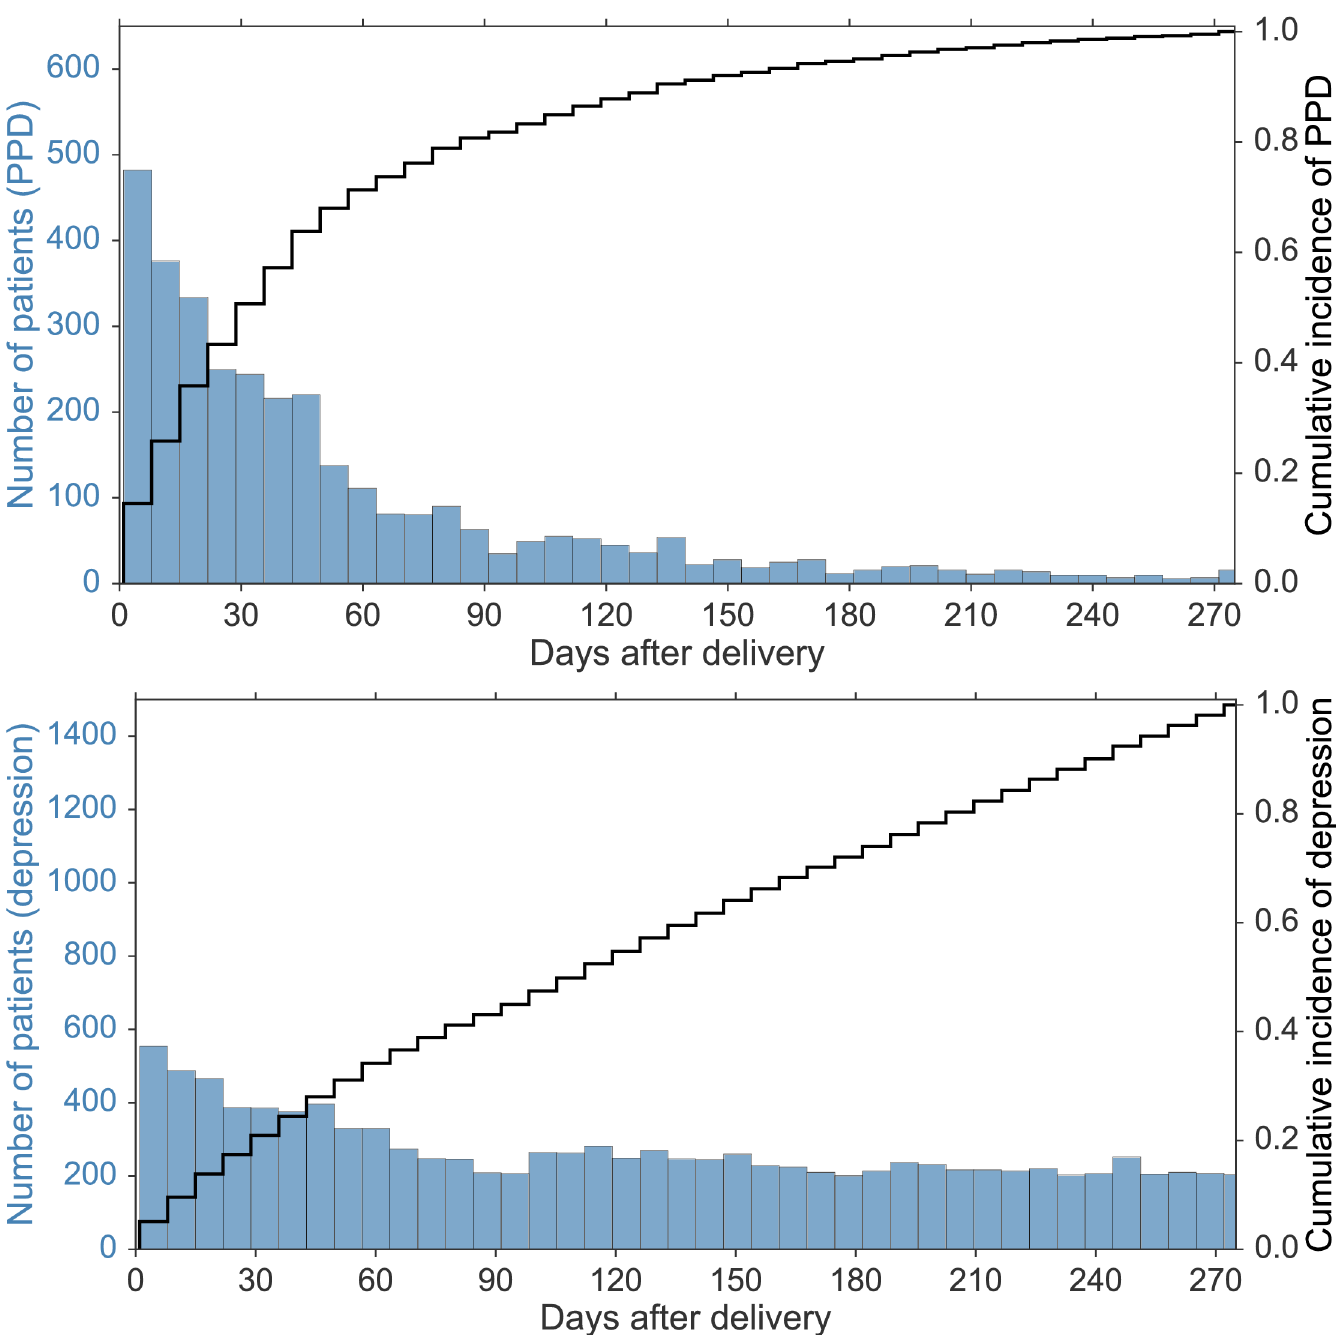
Fig 2. ( Top panel ) Timing of onset of the first ED visit or inpatient admission for a specific diagnosis of postpartum depression (PPD). Each vertical bar aggregates a week of hospital encounters. ( Bottompanel ) Similar histogram, but for the first hospital encounters for all severe